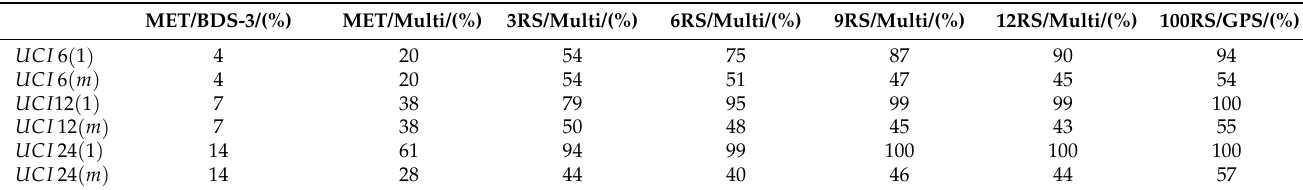
Table 3. GCF and uniformity of radio occultation